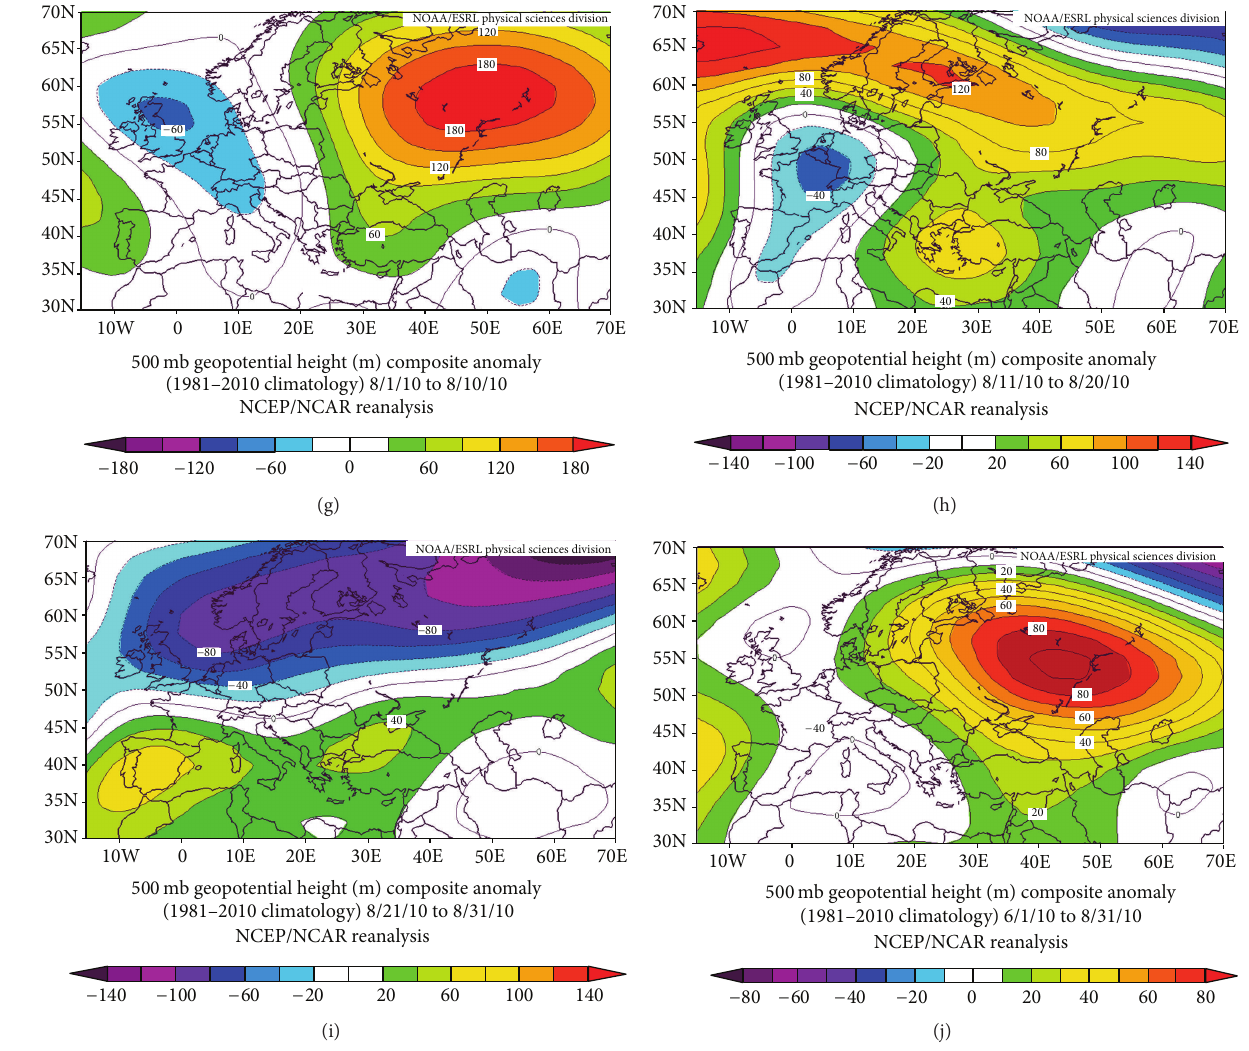
Figure 6: The 10 day anomaly composite mean of geopotential height at level 500hpa over Europe during summer season of 2010.